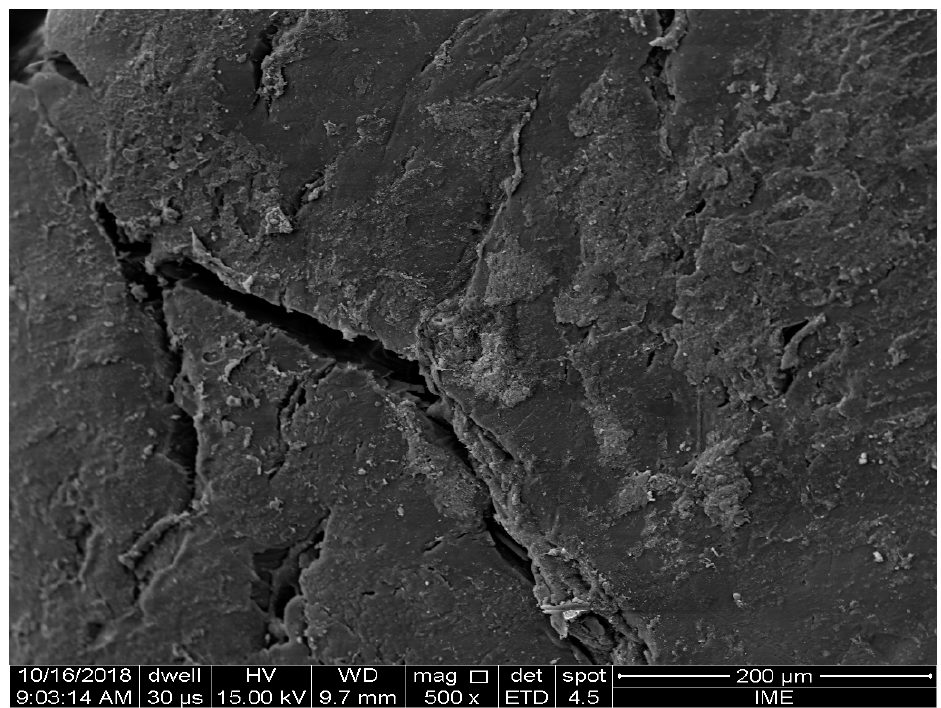
Figure 14. Scanning electron microscopy of PMMA based dental resins fragments/residues after depolymerization at 345 °C, atmospheric pressure, and 130 min (MAG: 500×).